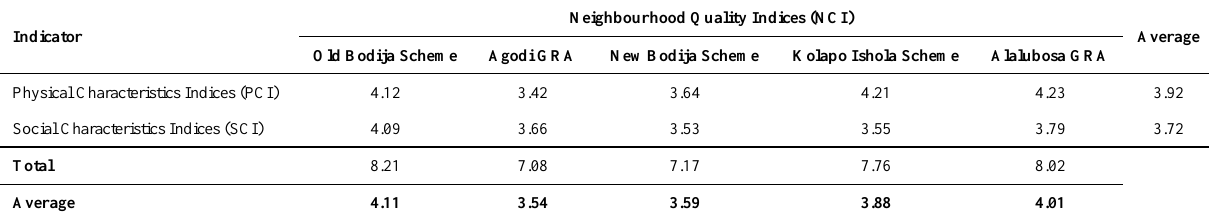
Table 14. Summary of the Neighbourhood Quality Indices (NCI) in the Study Areas